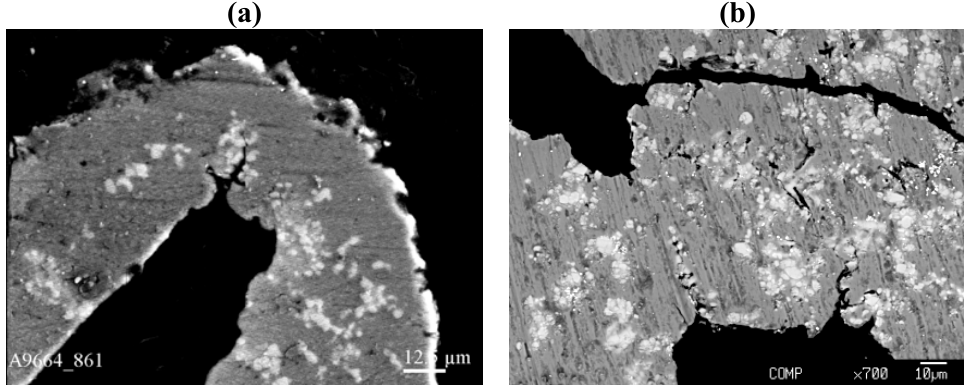
Figure 6 . SEM images of cracks in the cell walls of Al-foams ( a ) F1 and ( b )